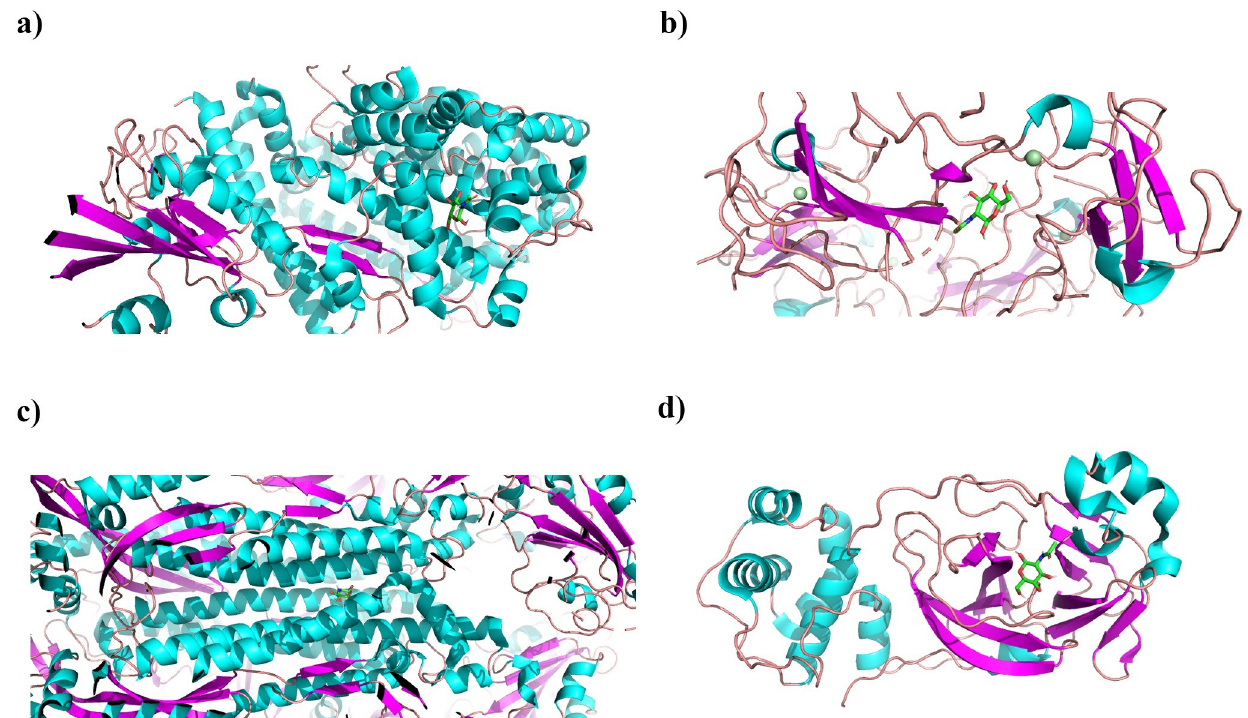
Fig 3. Best docking poses for tested proteins. Cartoon representation of the best docking pose of proteins (colored by secondary structures, clipped for visibility of the ligand) with D-GlcNAc for a ) 6M0J, b ) 6WKP, d ) 7JVZ, and ribbon representation to the best docking pose with D-GlcNAc for c ) 6X79. Figures were produced with PyMol